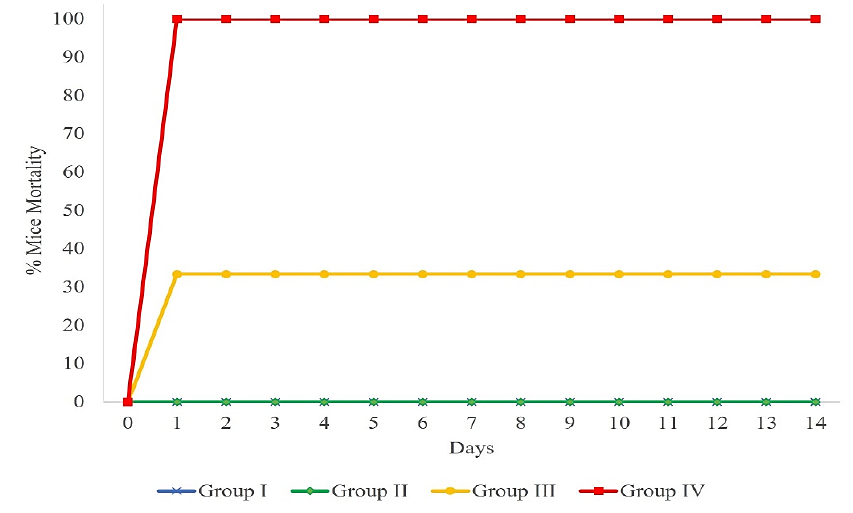
Figure 2. Percentage of mice mortality after challenge with ETEC H10407 strain for 14 days. Group I: normal saline (control group), n = 6; Group II: H10407 (10 ⁷ CFU), n = 6 ; Group III: H10407 (10⁸ CFU), n = 6; and Group IV: H10407 (10⁹ CFU), n = 6.